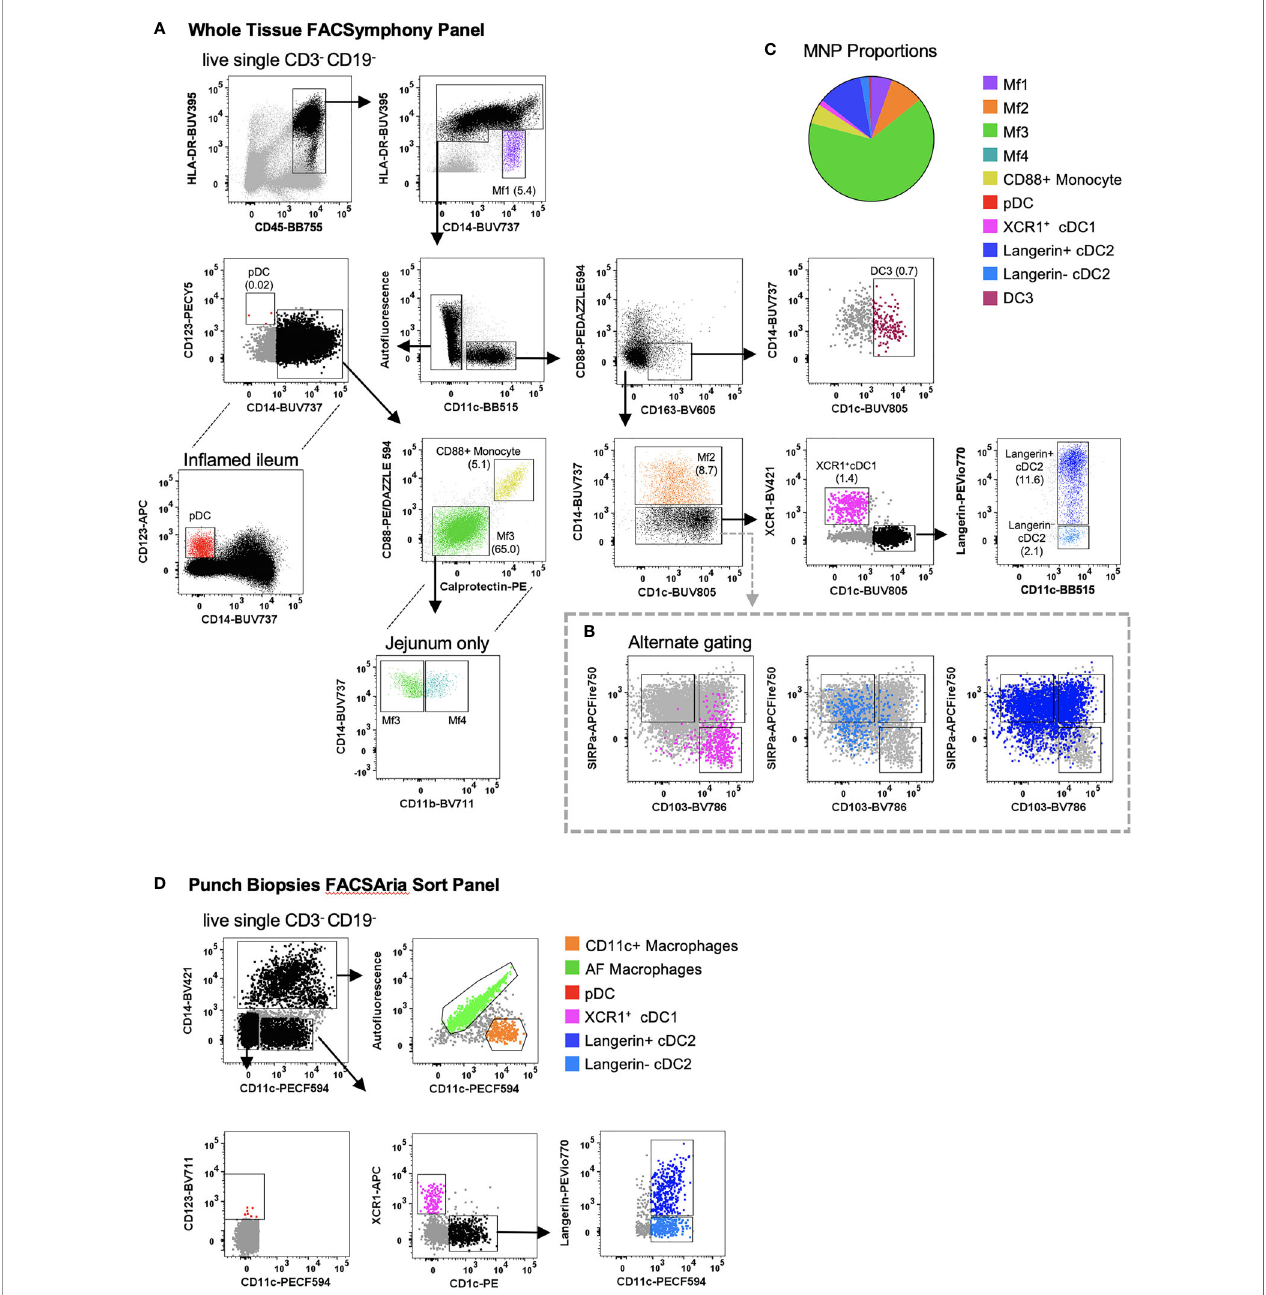
FIGURE 4 | Identi fi cation of intestinal-derived mononuclear phagocytes by fl ow cytometry. Intestinal mononuclear phagocytes were isolated as per Figure 1 . (A) Cells were stained with FACSymphony Phenotyping Panel ( Table 1 ). All mononuclear phagocytes were gated within the live, single, CD45 + CD3 - CD19 - population. Intestinal mononuclear phagocytes (MNP) were gated in sequential order with percentage of total mononuclear phagocytes in brackets. Macrophage (Mf) 1 were de fi ned as CD14 + HLA-DR low , with all sequential MNPs gated as HLA-DR + . Cells were then divided by their expression of CD11c. CD11c - cells included CD14 - CD123 + plasmacytoid DCs (pDCs), CD14 + Calprotectin + CD88 + monocytes and CD14 + auto fl uorescent + Mf3s which could be further subdivided into CD11b + Mf4 detectable only in the jejunum. CD11c + cells were divided as follows: CD88 - CD163 + CD1c + DC3s, CD14 + Mf2s, CD14 - CD1c - XCR1 + cDC1s, CD14 - XCR1 - CD1c + cDC2s divided by their expression of langerin. (B) Alternative gating for CD11c + CD14 - cells, characterised by SIRP a and CD103, overlaid with cDC1 and cDC2s from the main gating strategy for comparison. (C) Pie cart representation of proportion of mononuclear phagocyte subsets as part of whole of all mononuclear phagocytes (D) Cells isolated from intestinal biopsies were positively selected for CD45 and stained with FACS Sort Panel ( Table 2 ). Live, single CD45 + HLADR + cells were divided by CD14 expression. CD14 + cells were sorted as CD11c - auto fl uorescent + macrophages and CD11c + macrophages. CD14 - cells were sorted as CD123 + plasmacytoid DCs, XCR1 + cDC1s, CD1c + cDC2s langerin +/-